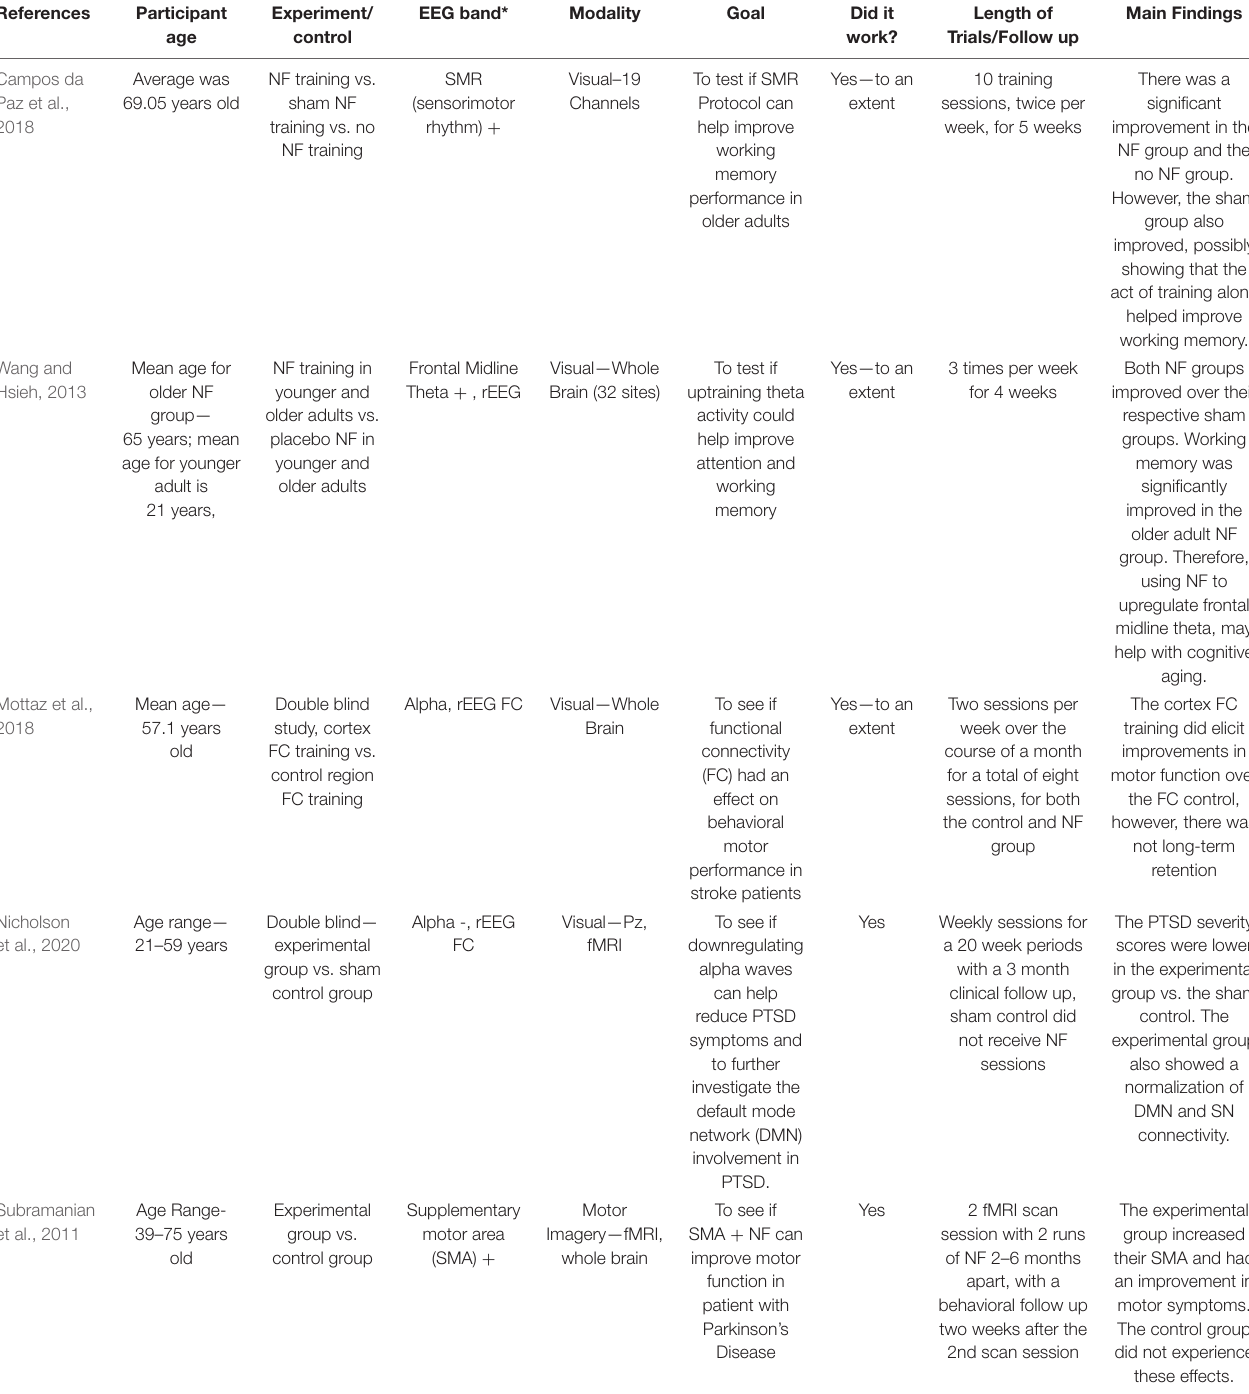
TABLE 3 | NF with control in working memory and cognitive